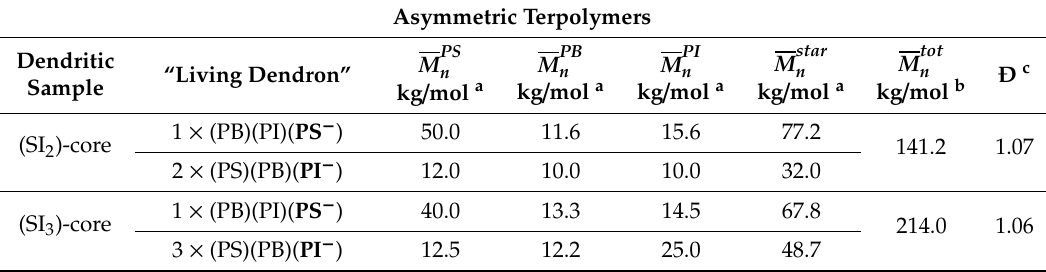
Table 2. Molecular Characteristics of the asymmetric dendritic terpolymers calculated by MO / VPO and